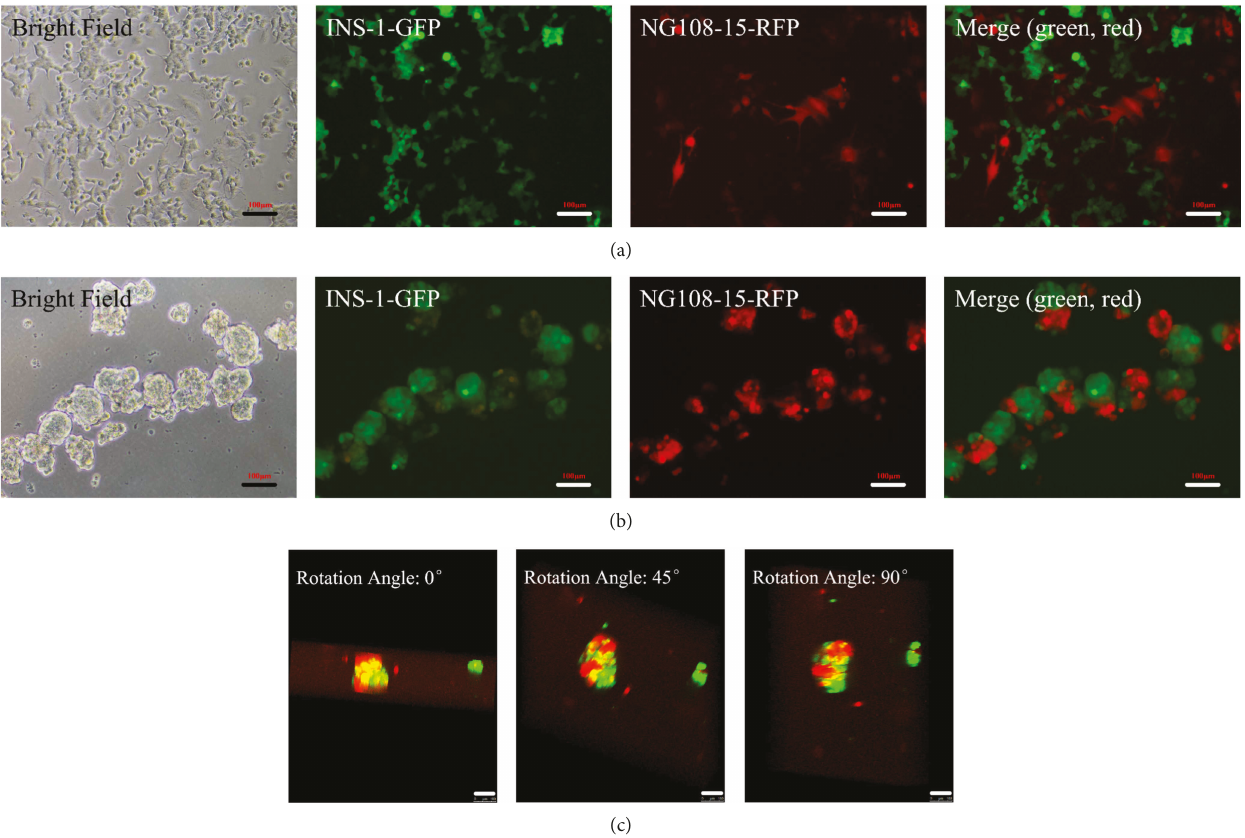
Figure 4: Morphological characterization of cells in coculture. (a) 2D coculture images (10x). (b) Heterotypic pseudoislet images (10x). (c) 3D reconstruction images of heterotypic pseudoislets were taken from di ff erent angles (20x). (a, b, and c) Green cells: INS-1 cells and red cells: NG108-15 cells. Scale bars: 100 μ